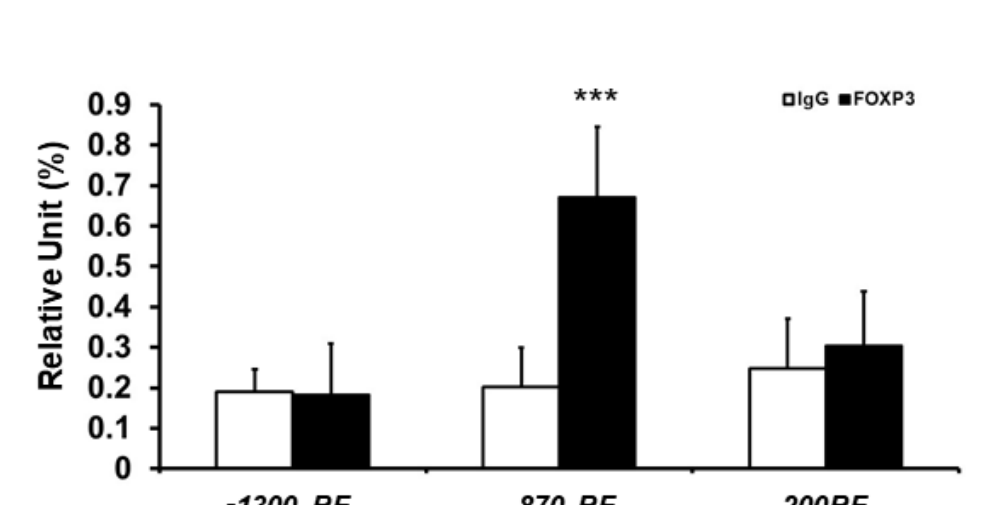
Figure 3. Regions of ATF3 promoter important for transcriptional down-regulation by FOXP3. ( A ) MCF7 cells were co-transfected with ATF3 promoter deletion constructs and FOXP3 expression plasmids. Luciferase activities were measured 48 h after transfection and normalized with Renilla activity. Relative LUC activity was calculated and plotted. ( B ) MCF7 cells were co-transfected with FOXP3 expression plasmids and with either wild-type (with − 870 FOXP3 RE) or mutant (with − 870 FOXP3 RE mutated) ATF3 promoter constructs. Luciferase activities were measured 48 h after transfection and normalized with Renilla activity. Relative LUC activity was calculated and plotted. ( C ) The quantification of the amount of DNA fragment precipitated (expressed as relative unit as a percentage of the total input DNA) in chromotin immunoprecipitation (ChIP) assay and qPCR analysis of possible FOXP3-binding sites ( − 200 RE, − 870 RE, and − 1300 RE) in the ATF3 promoter region in MCF7 cells. The experiments were performed two times. *** indicates p < 0.001 vs. IgG.